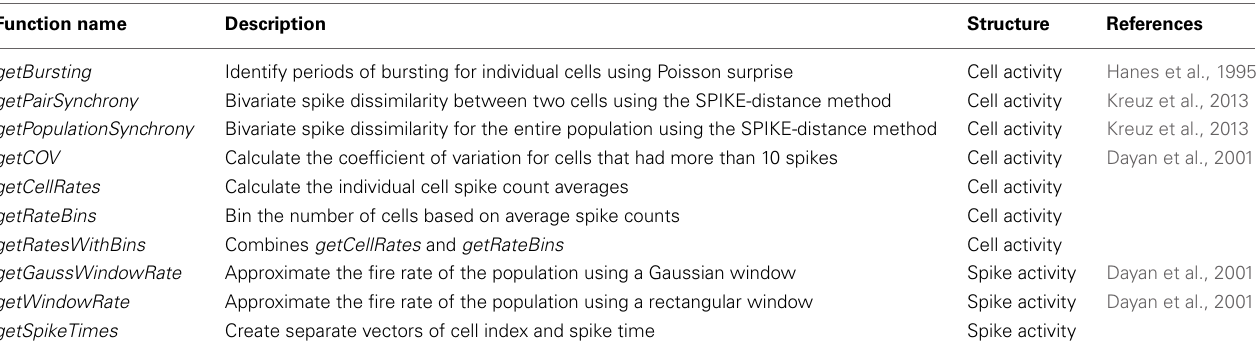
Table 1 | HRLAnalysis ™ spike analysis functions currently